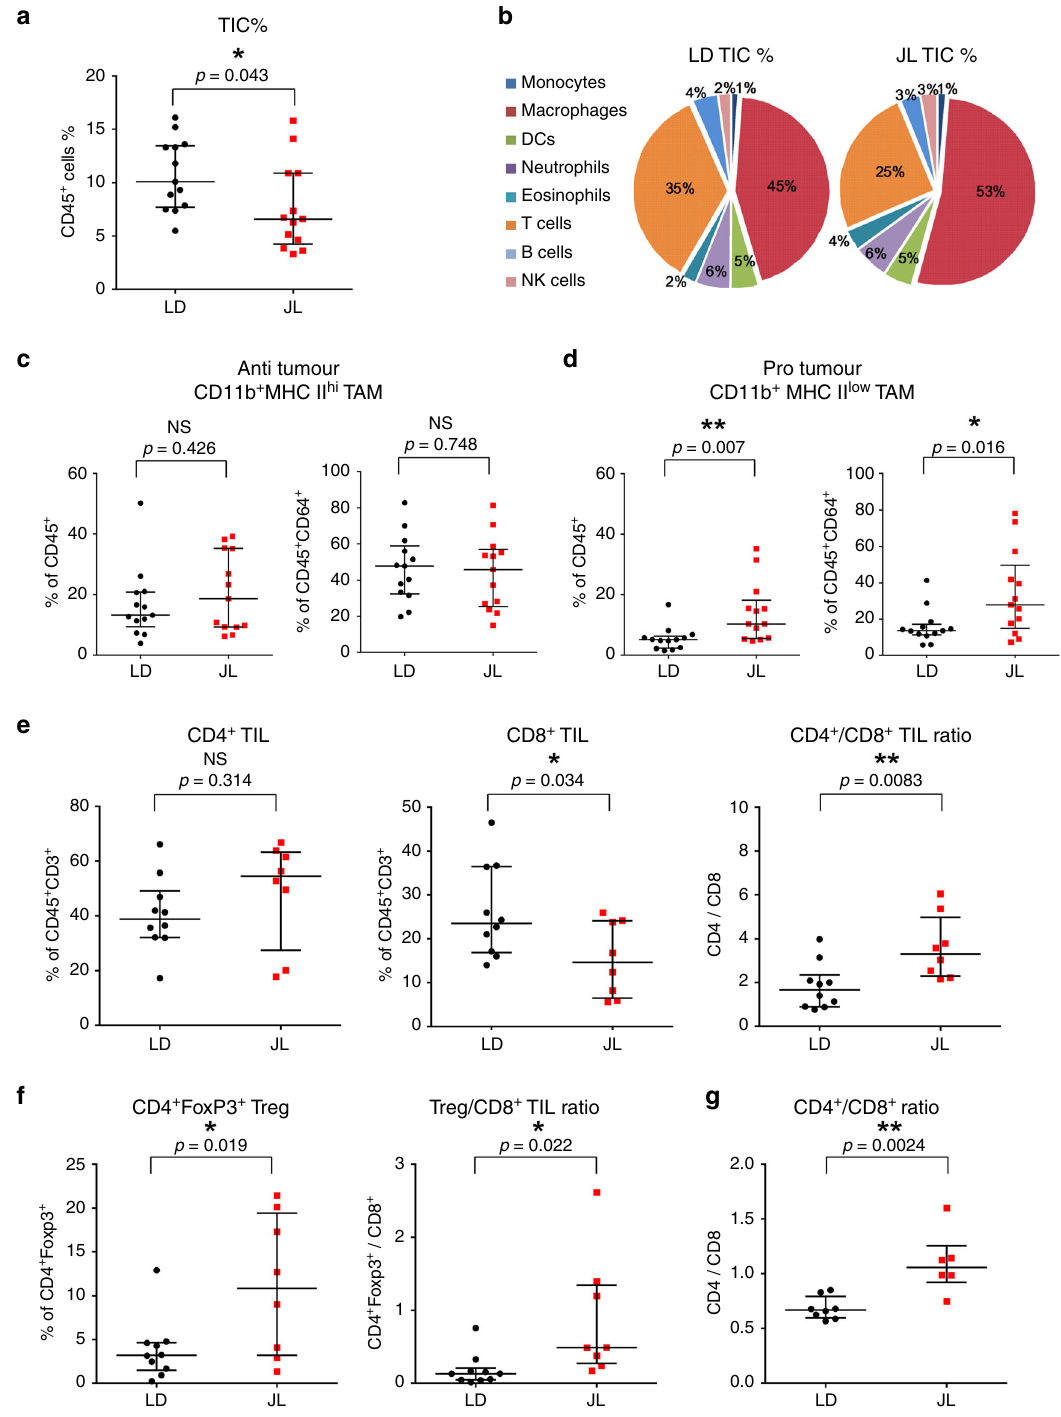
Fig. 5 Chronic circadian disruption attenuates immune in fi ltration and creates a pro-tumour immune microenvironment. a Percentage of tumour- in fi ltrating immune cells (TIC) in LD ( n = 13) and JL ( n = 13) tumours. Flow cytometric analysis revealed a lower percentage of TICs in JL tumours. Data are presented as a scatter dot plot with lines indicating the median with interquartile range (error bars). P -value obtained from an unpaired two-sided t -test. b Relative distribution of main immune cell types in TICs from LD and JL tumours. Data presented as pie charts displaying the mean values of 13 mice. c , d Tumour-associated macrophage (TAM) phenotypes in LD ( n = 13) and JL ( n = 13) tumours. Flow cytometry of JL tumours showed a signi fi cant reduction in the anti-tumour CD11b + MHC II hi phenotype, with a signi fi cant increase in pro-tumour CD11b + MHC II low TAMs. e Tumour-in fi ltrating lymphocytes (TIL) in LD ( n = 10) and JL ( n = 8) tumours. TILs are presented as percentage of CD3 + immune cells. The proportion of CD8 + TILs was signi fi cantly lower in JL tumours, resulting in an increase in the CD4/CD8 ratio. f Tumour-in fi ltrating CD4 + FoxP3 + T cells in LD ( n = 10) and JL ( n = 8) mice. Flow cytometry revealed a signi fi cant increase of Treg and Treg/CD8 + ratio in primary tumours of JL mice. g CD4/CD8 ratio in the peripheral blood of LD ( n = 8) and JL ( n = 6) mice. c – g Data are presented as scatter dot plots with lines indicating the median with interquartile range (error bars). P -values obtained from unpaired two-sided t -test. Indicated ( n ) represent number of independent experiments as biological